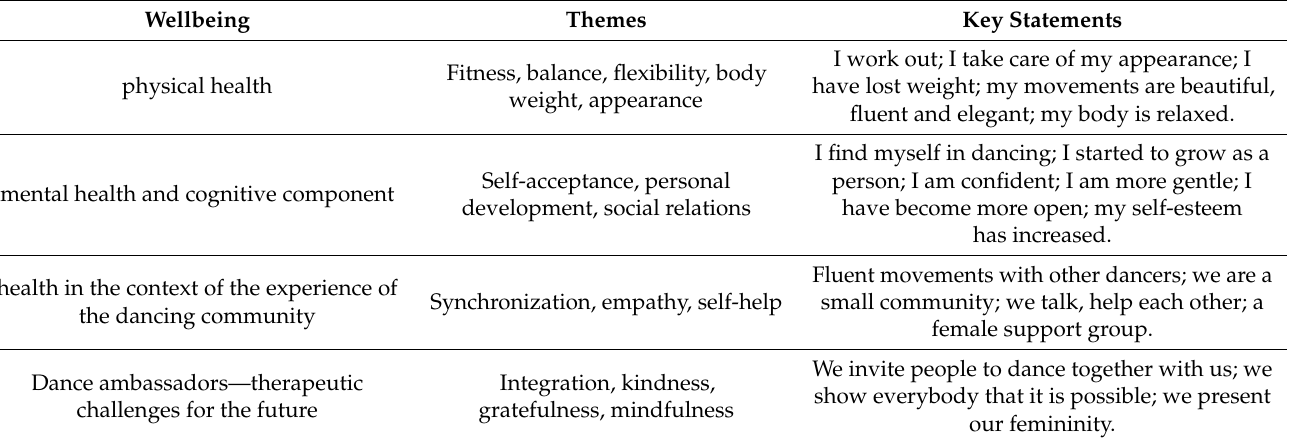
Table 1. Well-being with corresponding themes and key